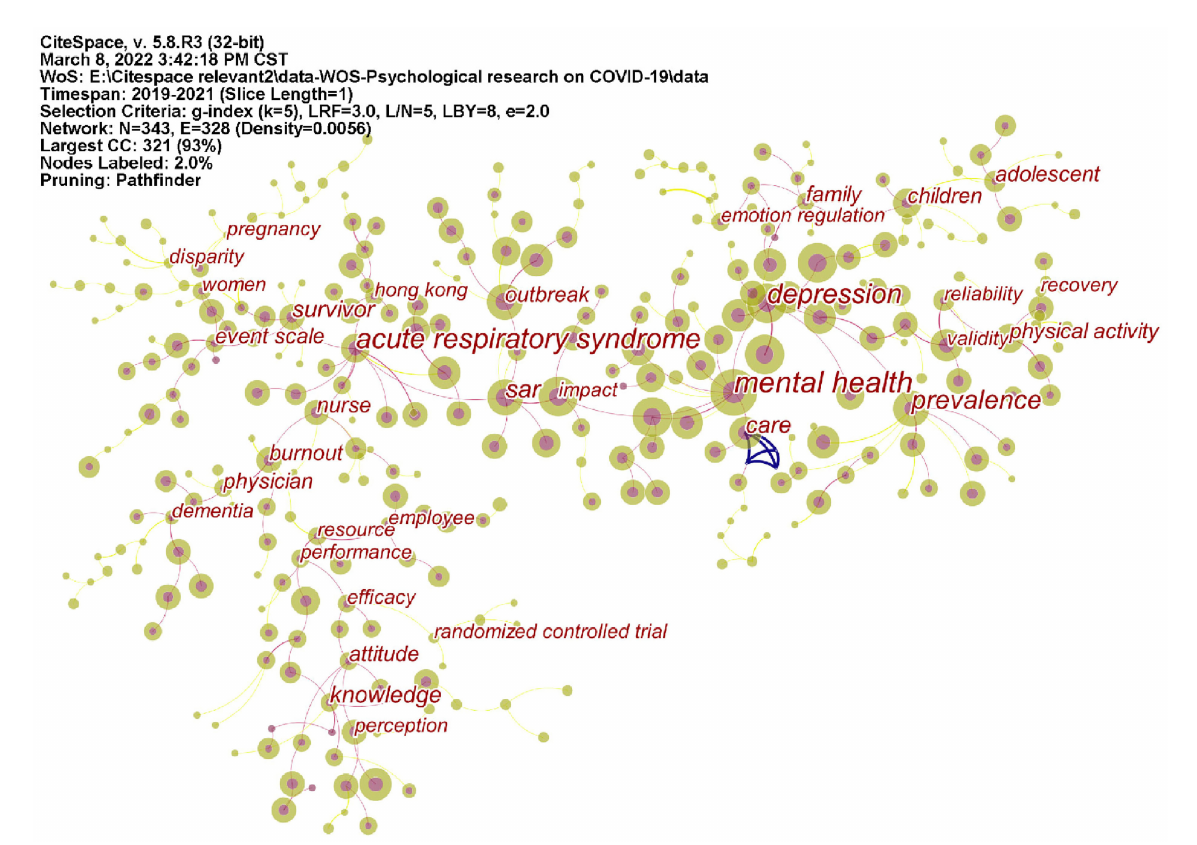
FIGURE5 Keywords co-occurrence map of mental health research related to